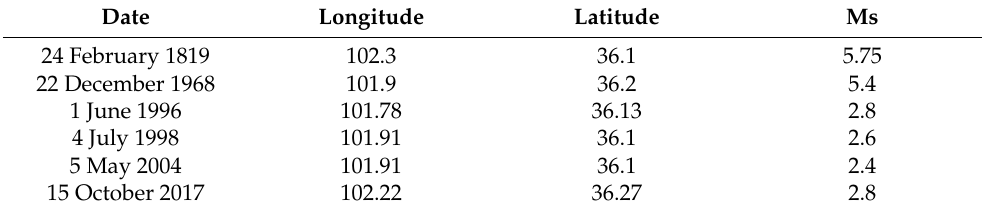
Table 1. Catalog of historical earthquakes in the study area.